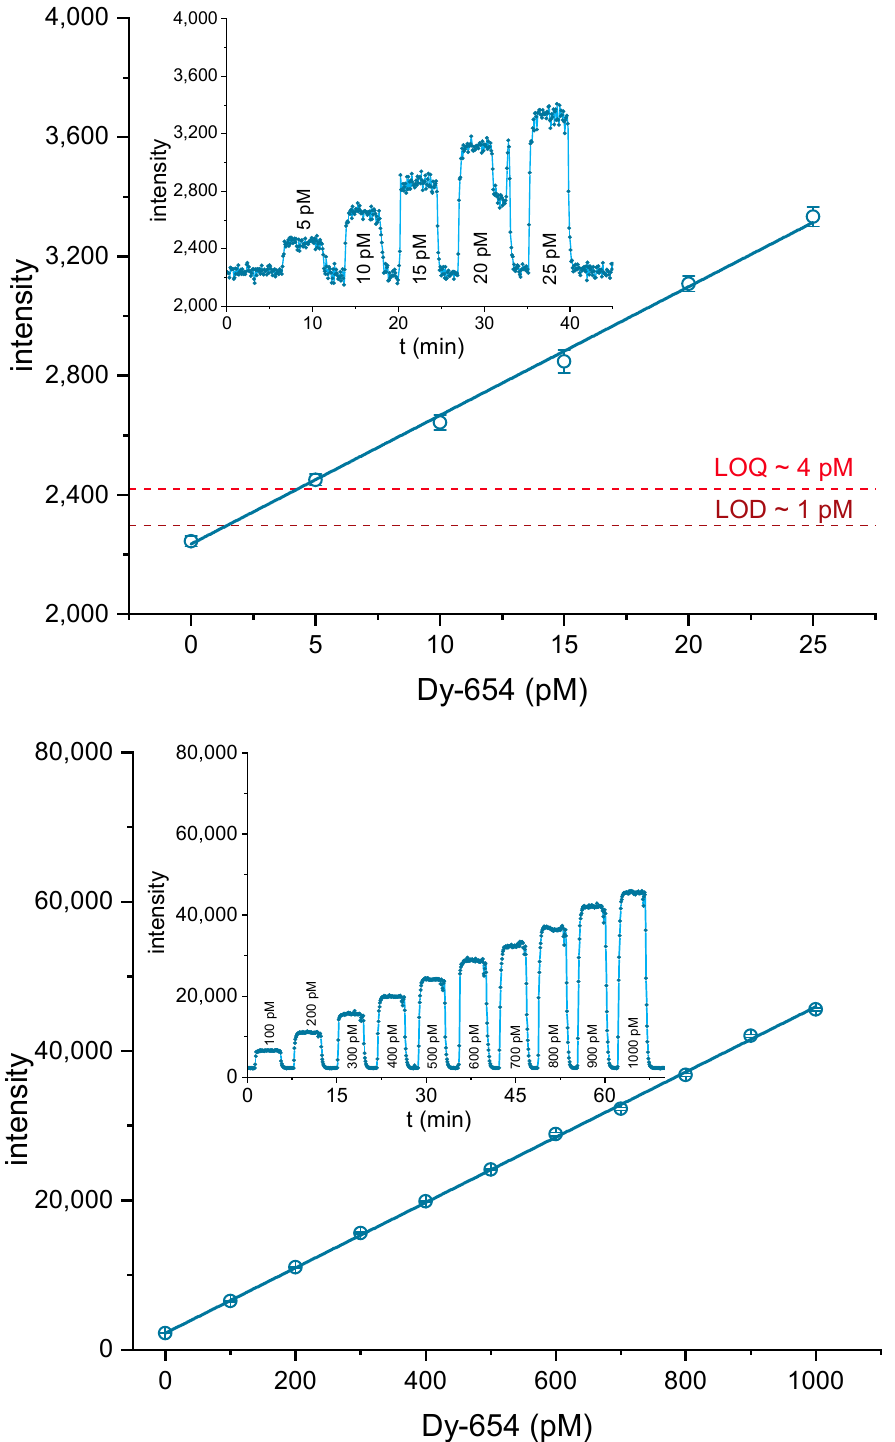
Figure 6. Determination of the limit of detection (LOD) (3s) and LOQ (10s) for the fluorescence label Dy-654-COOH (top) and calibration line in the linear range from 4–1000 pM (bottom).